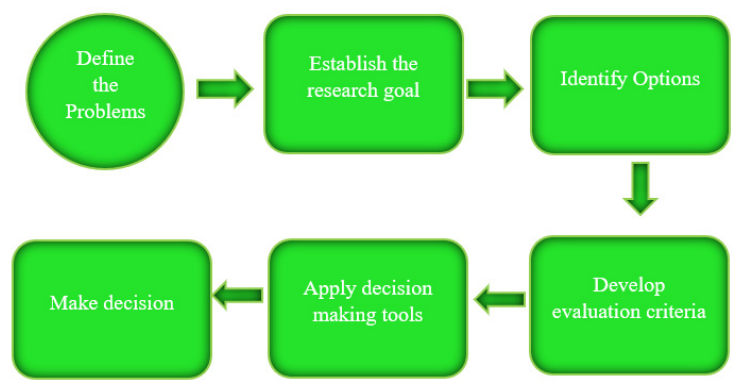
Figure 1. The MCDM model’s processes.